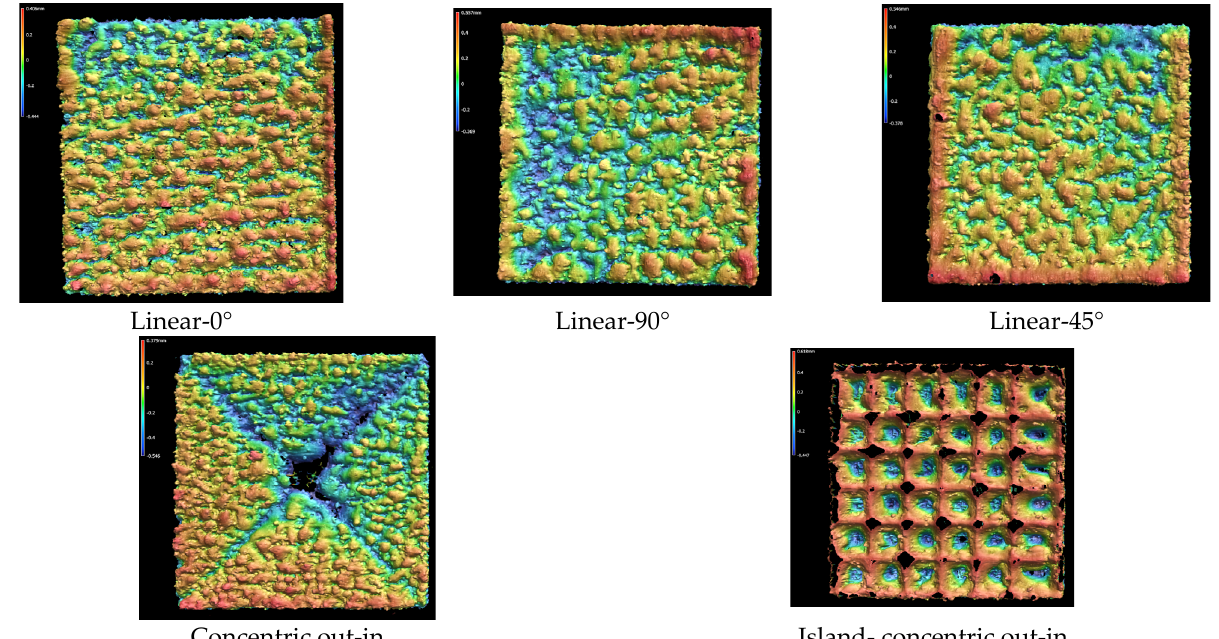
Figure 14. 3D microscopic analysis for the alumina samples (10 × 10 × 10 mm 3 ) printed using different scanning